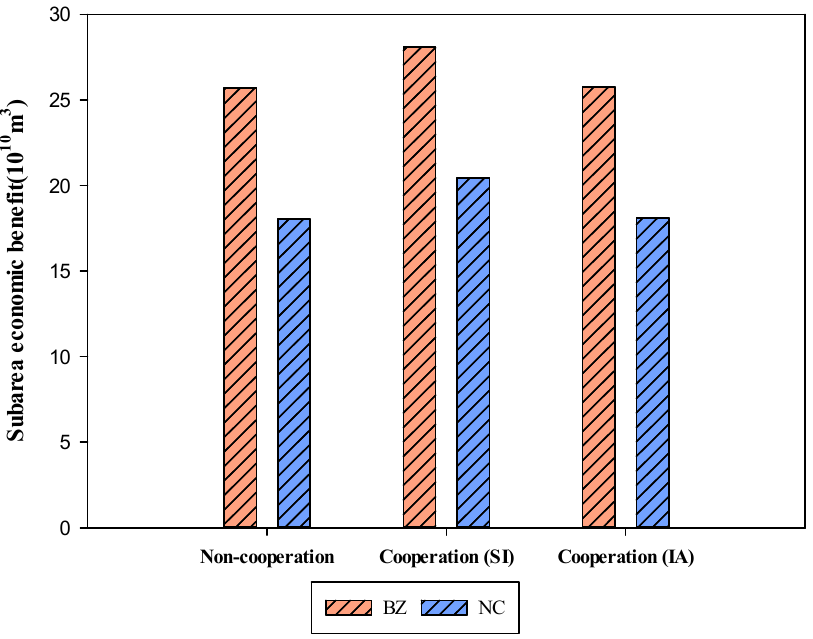
Figure 4. Economic benefits of BZ and NC in different situations. Note: symmetric information (SI), information asymmetry (IA).